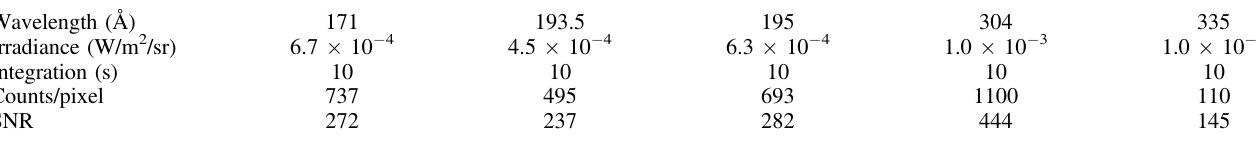
Table 4. The SunCET spectrograph SNRs for various strong emission lines. Irradiances are from SDO/EVE (Woods et al., 2011). SNR at all heights is above the level that ISO 12232 de fi nes as “ excellent ”